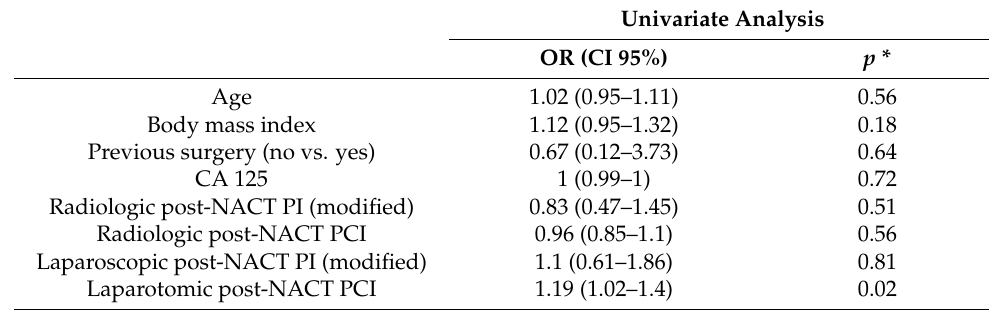
Table 5. Univariate analysis of the factors predicting complete cytoreduction (R0) at the time of primary debulking surgery. NACT: neoadjuvant chemotherapy; PI: predictive index; PCI: peritoneal cancer index; OR: odds ratio; CI: confidence